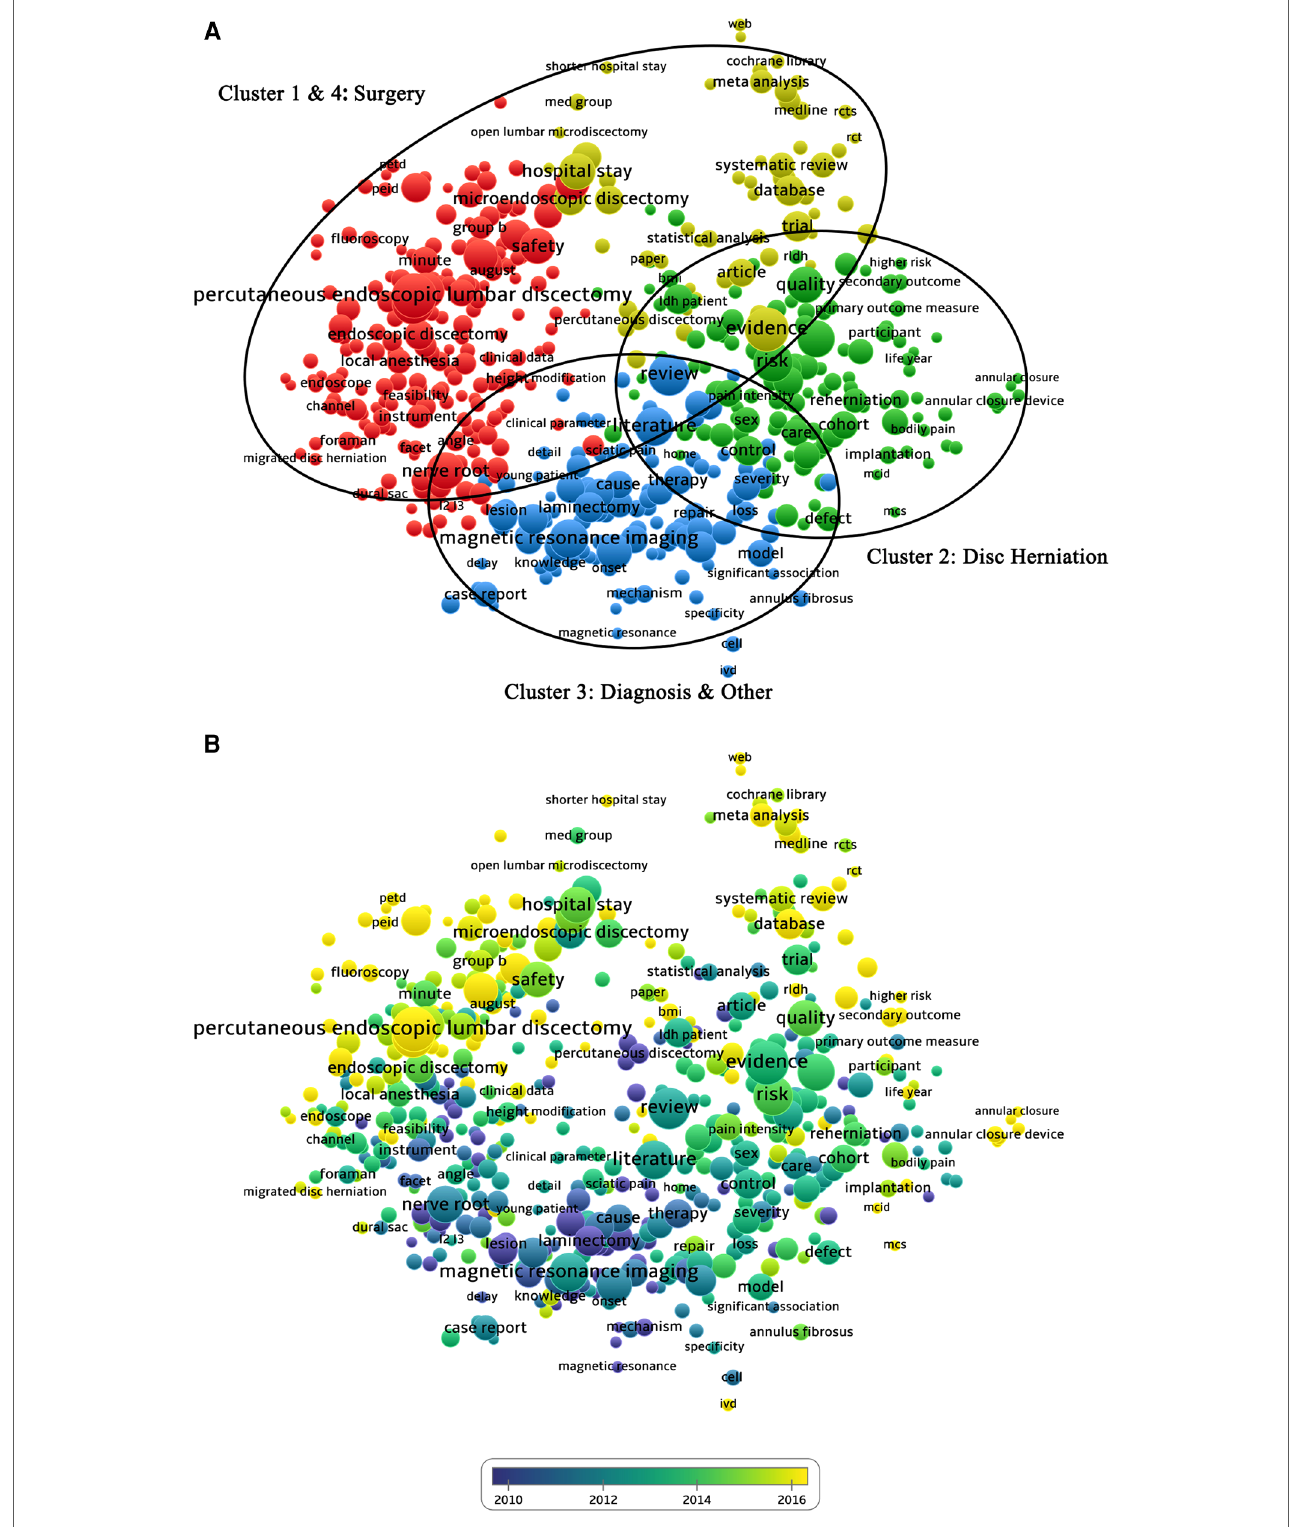
FIGURE 3 ( A ) Mapping of hotspots in the research on discectomy; the size of the points represents the frequency, and the hotspots are divided into four clusters: surgery (red and yellow clusters in the upper left corner), lumbar disc herniation (green clusters on the right), and diagnoses (blue clusters at the bottom). ( B ) Distribution of hotspots according to the appearance for the average time; hotspots in blue appeared earlier than those in